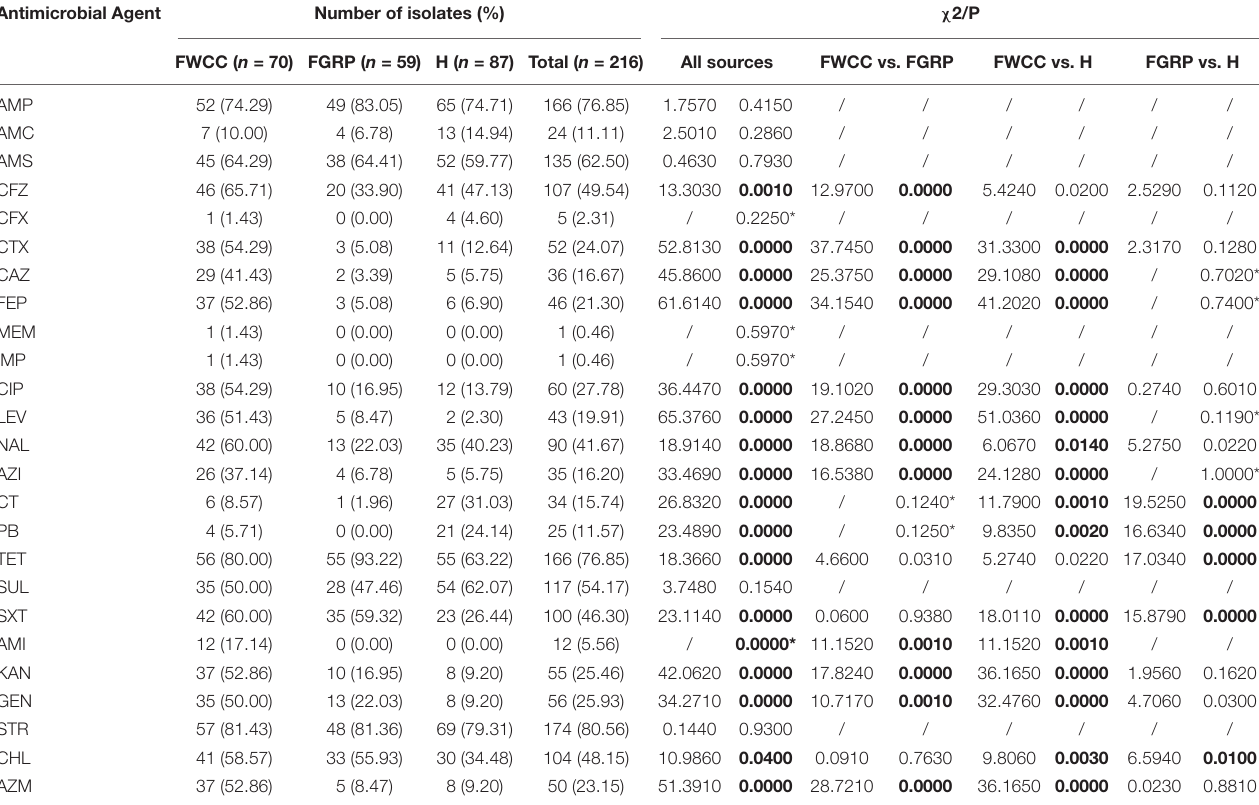
TABLE 2 | Antimicrobial susceptibility testing and comparison of the resistance of Salmonella isolates from different sources. Antimicrobial Agent Number of isolates